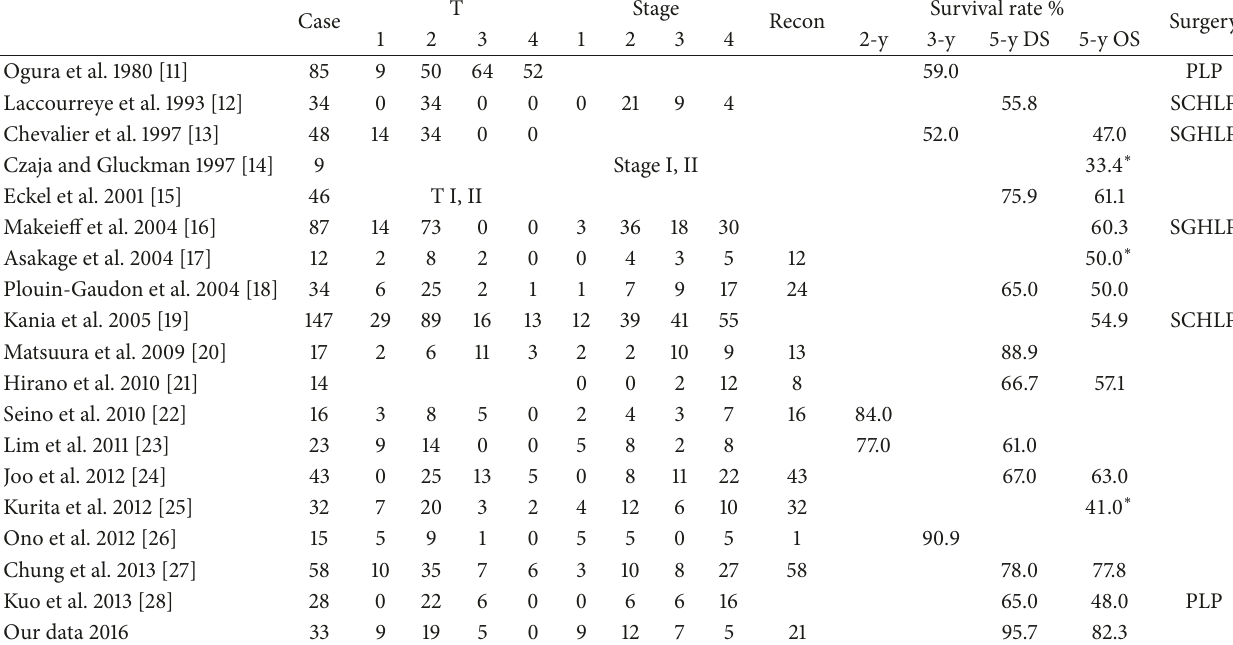
Table 4: Review of the